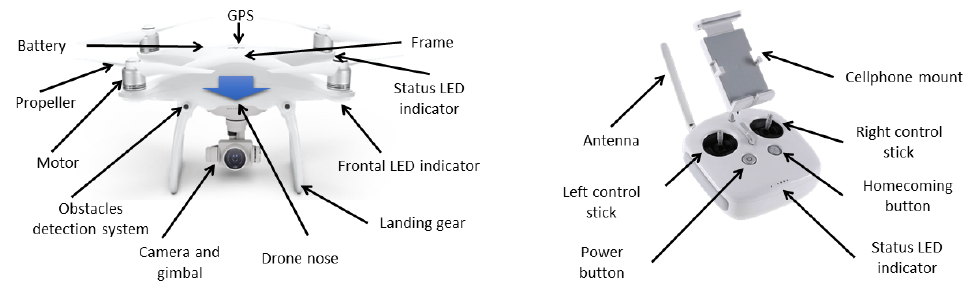
Figure 3. Drone in the MoCap